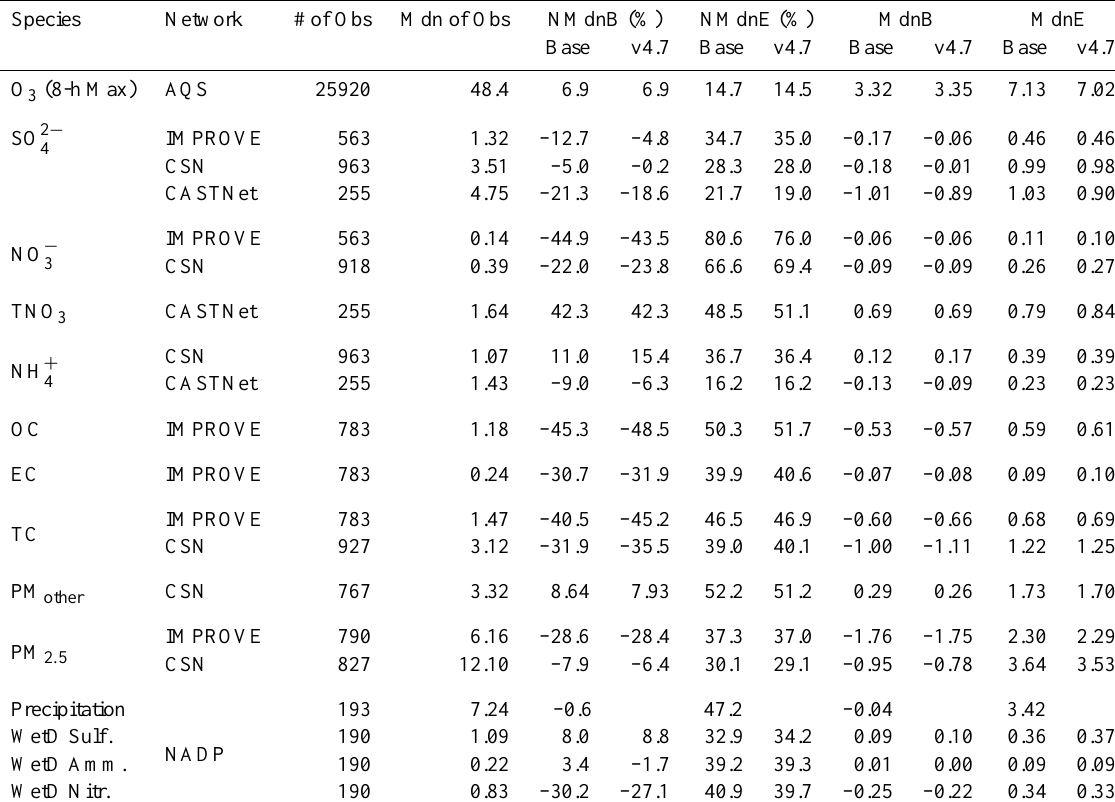
Table 4. RMSE, NMdnB, NMdnE, MdnB and MdnE for O 3 (ppb), fine-particulate mass and species (µg/m 3 ), precipitation (cm) and wet deposition species (kg/ha) for August 2006. These metrics are defined in Table